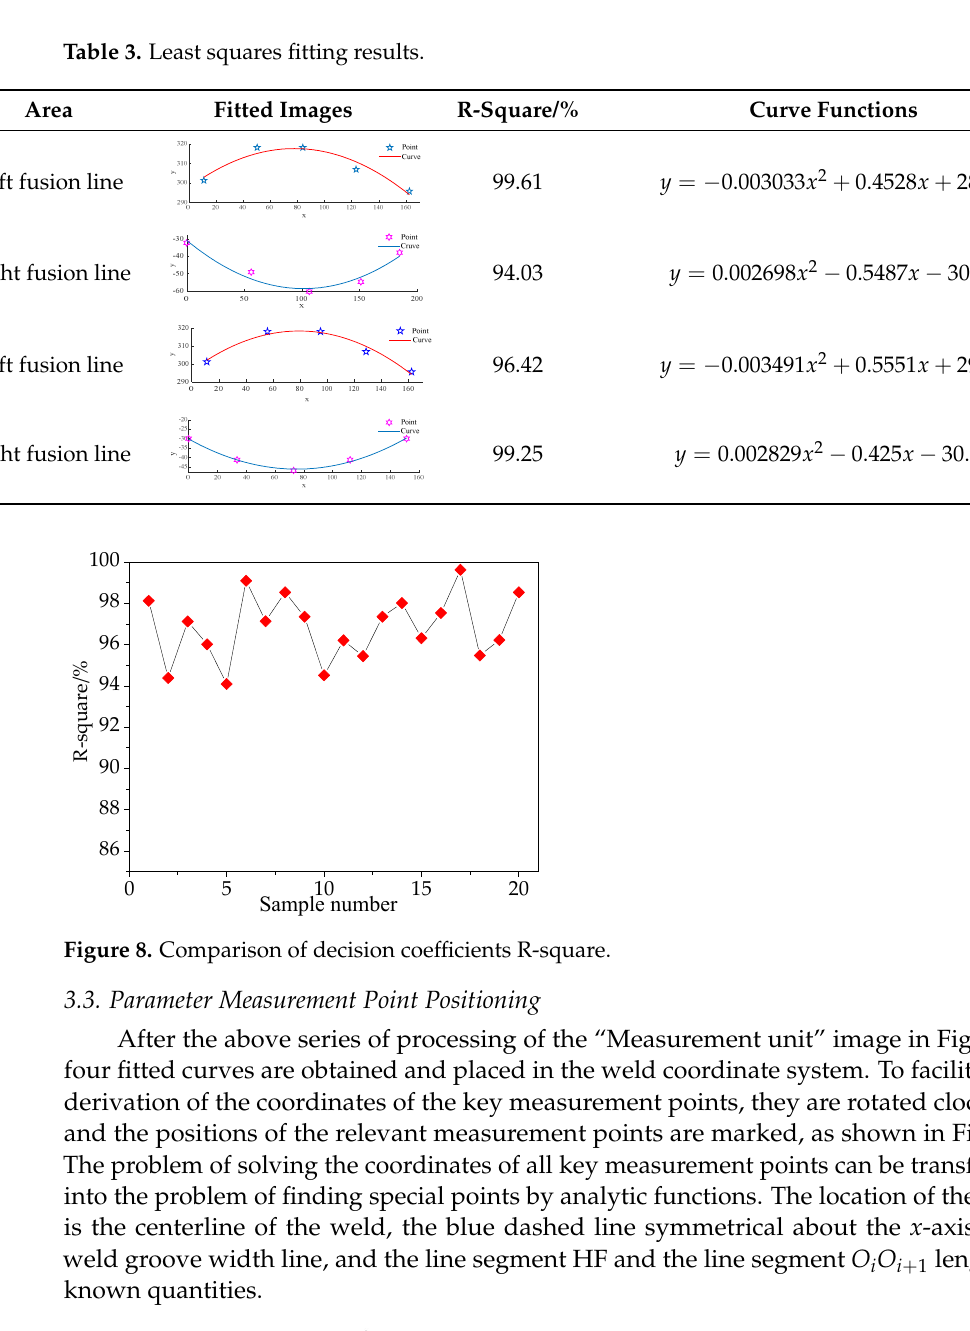
Figure 8. Comparison of decision coefficients R ‐ square.